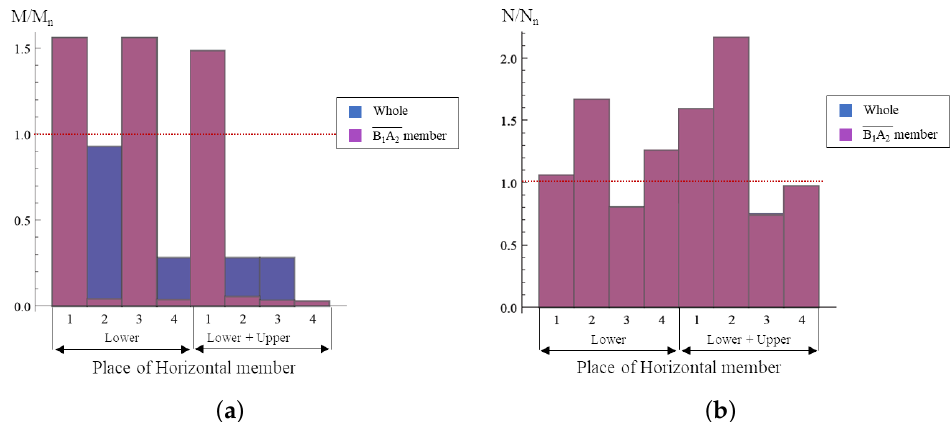
Figure 11. Summarized sectional forces in the two units model according to the reinforcing layouts: ( a ) nondimensional bending moment; ( b ) nondimensional axial